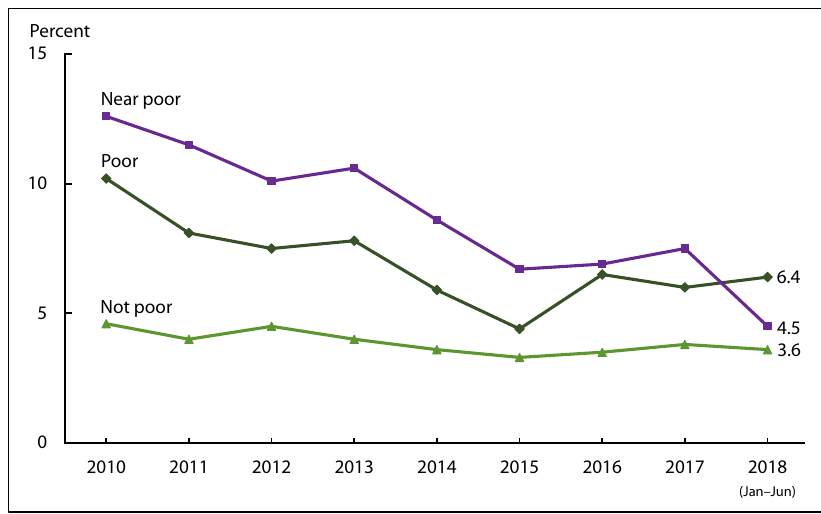
Figure 5. Percentage of children aged 0 – 17 years who were uninsured at the time of interview, by poverty status: United States, 2010–June 2018